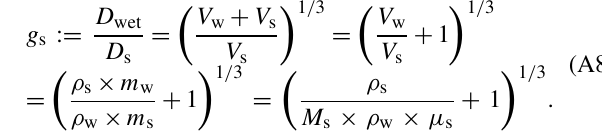
EQSAM4clim (see Sect. B), to determine ν i for different T